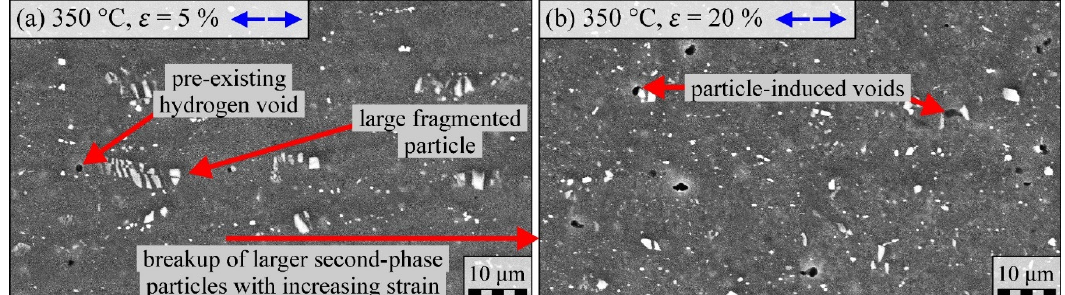
Figure 9. Exemplary SEM images of the sample cross-section of a sample tested at 350 °C ( a ) slightly further from the fracture surface with low strains and ( b ) near the fracture surface with correspondingly higher local strain.